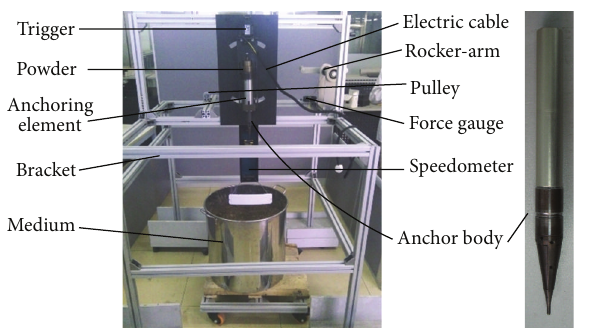
Figure 5: Testing platform of the anchoring system.